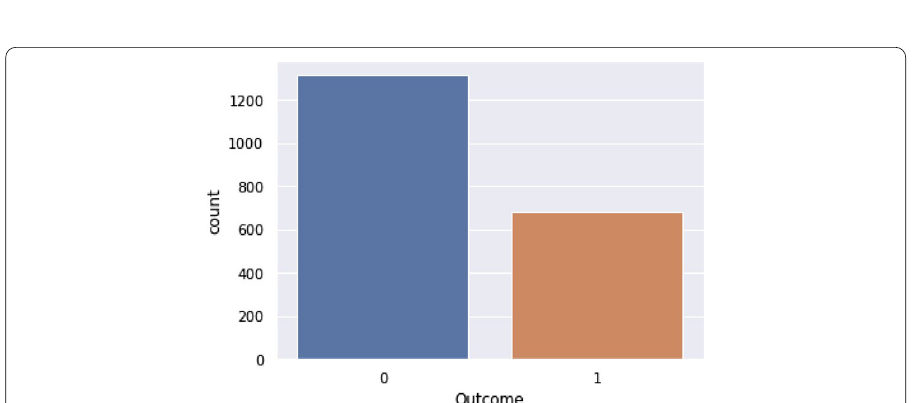
Fig. 8 Population distribution of the Dataset2 0: diabetic cases, 1: non-diabetic